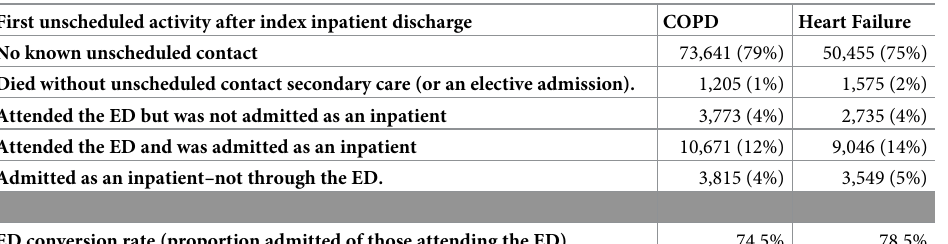
Table 2. First unscheduled activity after the index inpatient discharge (elective admissions have been included for additional information, although these are not ‘unscheduled’). All outcomes are all-cause.